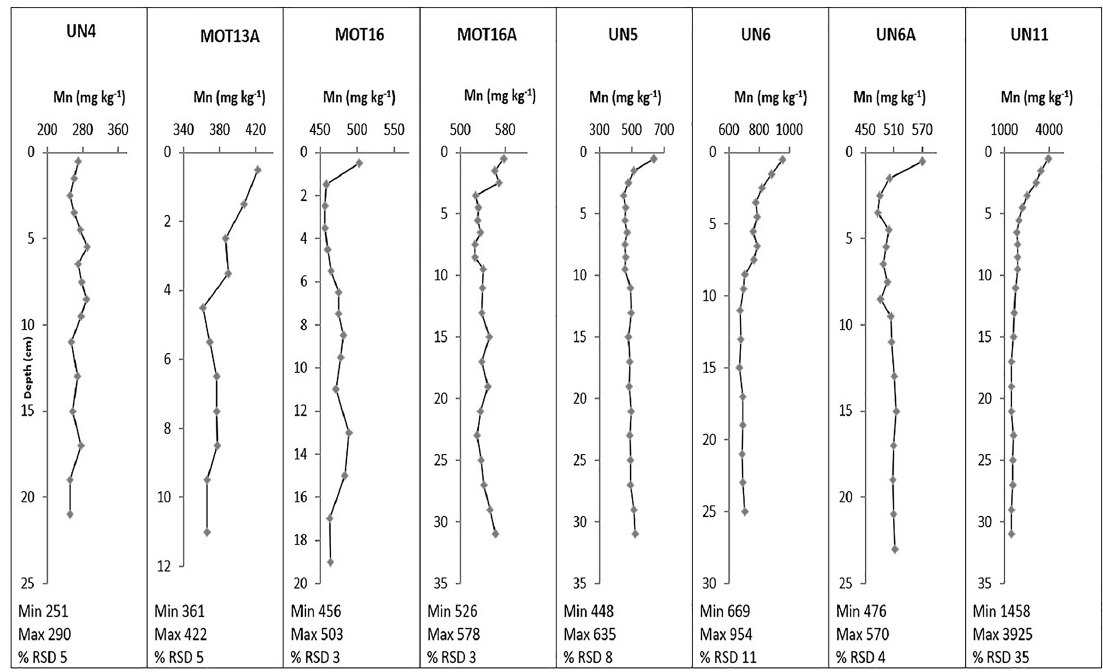
Figure A8. Vertical distributions of Mn (in mgkg − 1 ) in sediment cores. The concentrations in the coarse cores MOT13A, MOT16 and UN4 refer to the total sediment fraction ( <